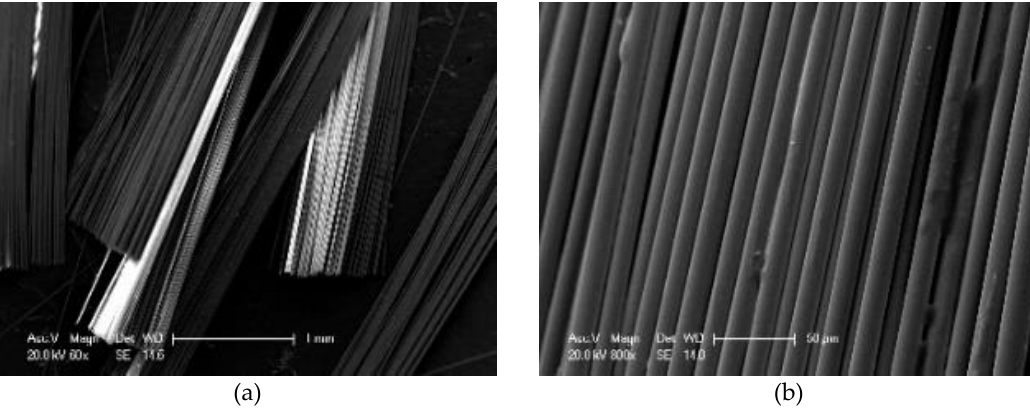
Figure 13. Micro image of BF: ( a ) 60×; ( b ) 800×.